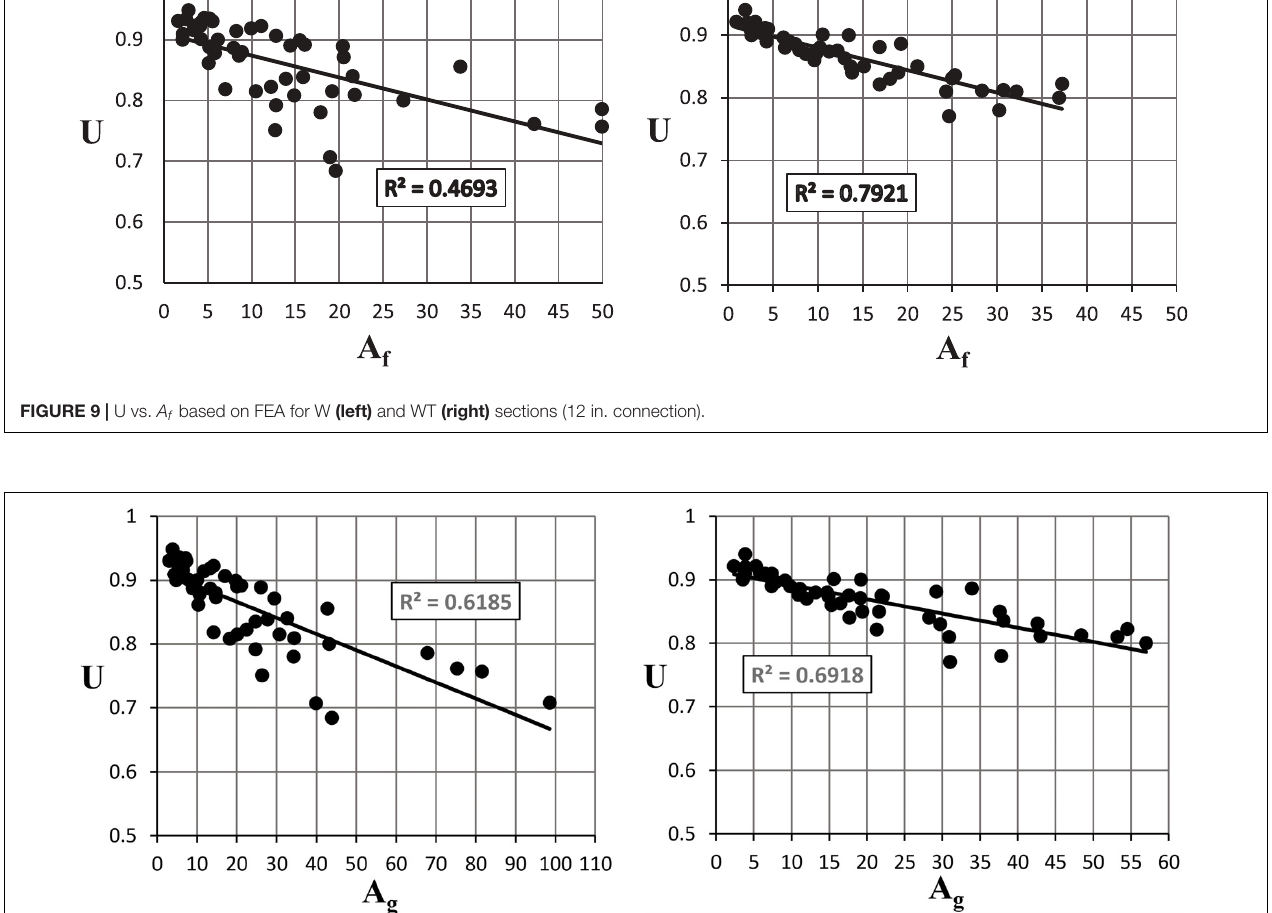
Frontiers in Built Environment |